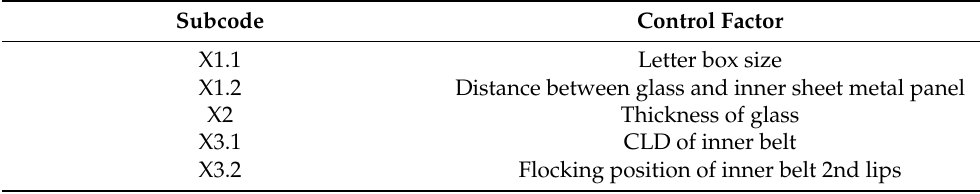
Table 2. Control